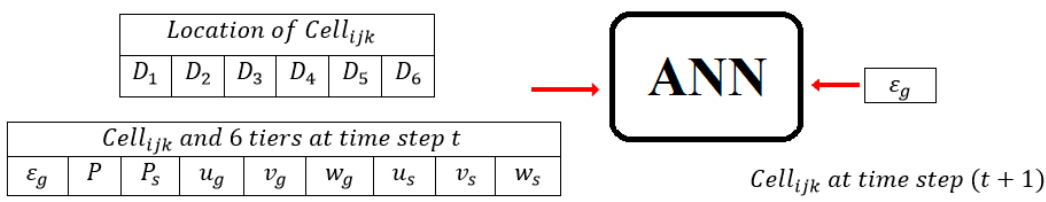
Figure 12. Input and computational fluid dynamics (CFD) output parameters used for training. Figure 11. Gas volume fraction distribution initially in the bed at time-step = 100 ( a ) and later when it is fully fluidized at time-step = 4000 ( b ).